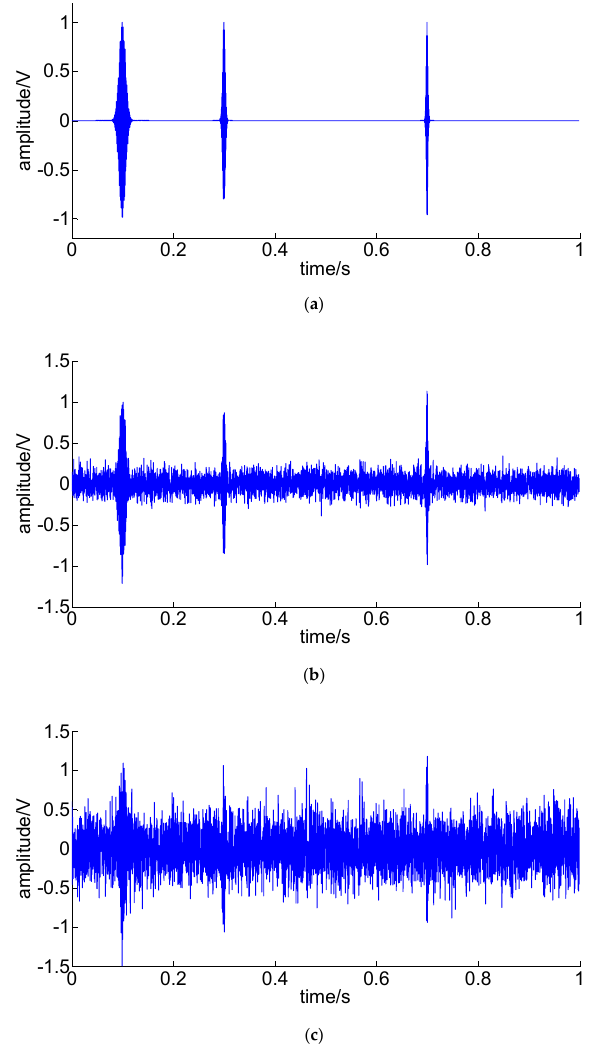
Figure 5. The simulated signals: ( a ) S 1 : noise-free signal; ( b ) S 2 : noisy signal, SNR = − 3.16 dB; ( c ) S 3 : noisy signal, SNR = − 8.75 dB.